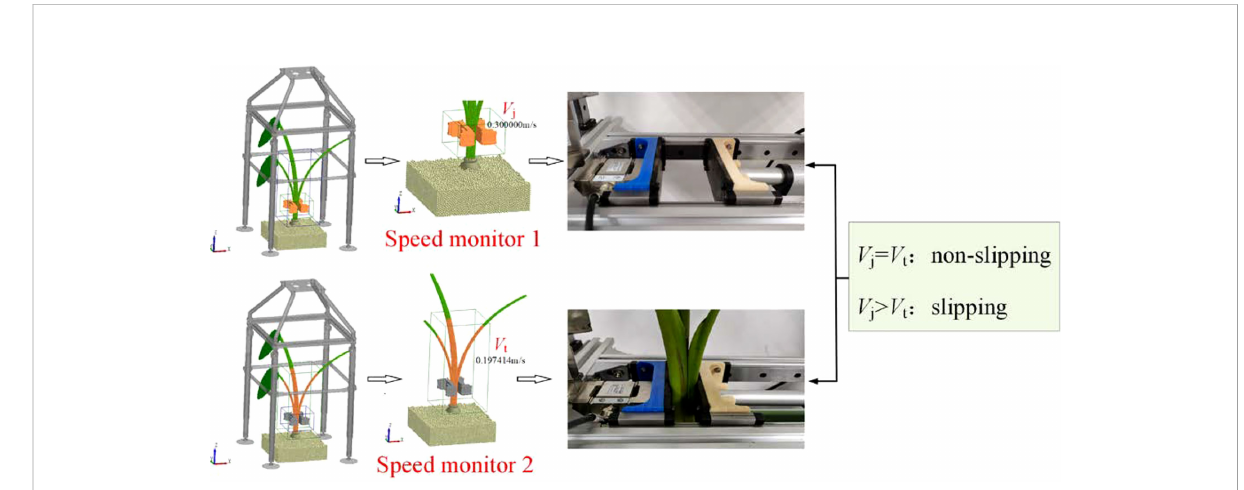
FIGURE 8 The speed monitor established by the simulation